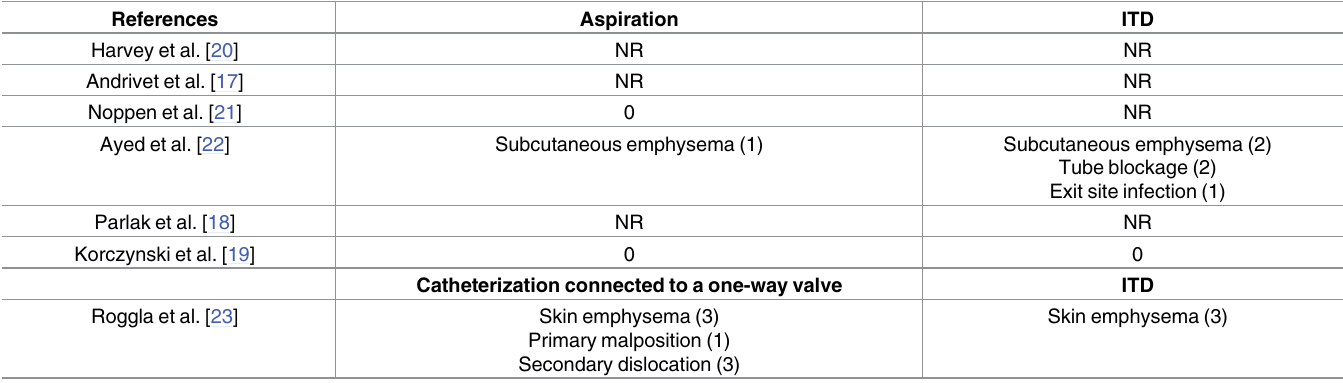
Table 3. Complications in the intervention and control arms of each